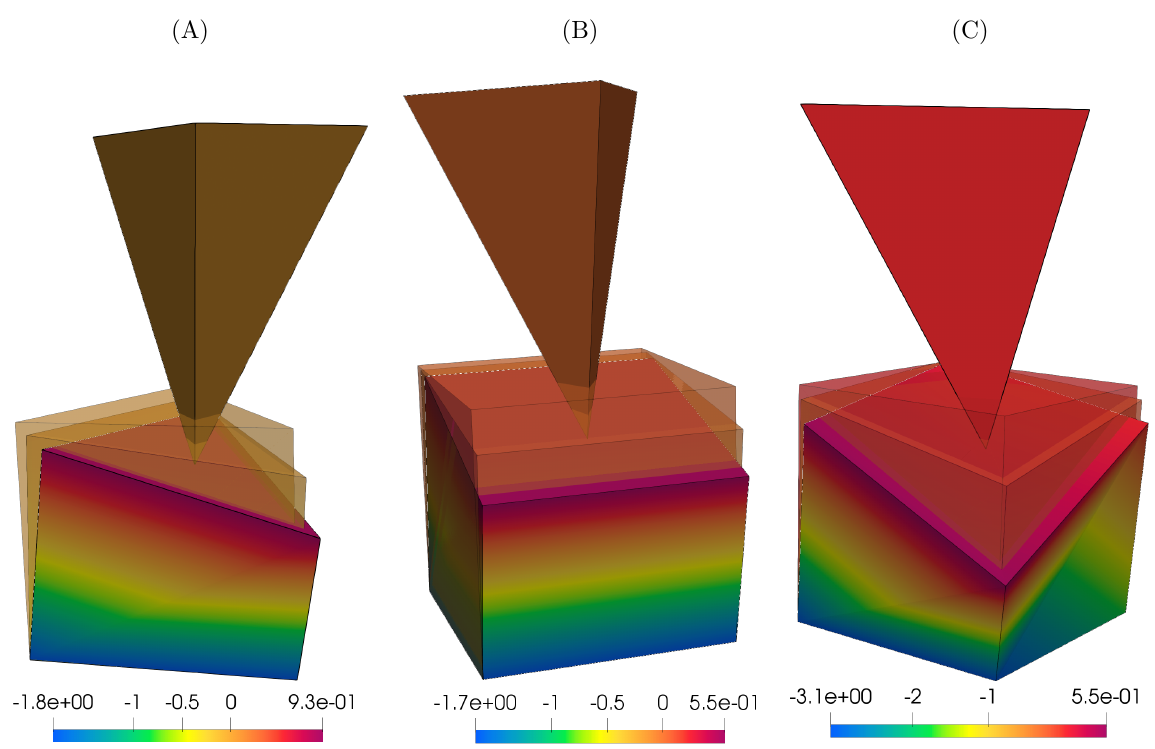
Figure 2. Node-to-segment contact with penalty formulation in the 3D domain: tests on a linear wedge and a linear brick element. Displayed geometries correspond to the 0th (undeformed configuration), 40th, and 60th steps of the computation. Coloring represents the vertical normal stress σ . A) A test on a linear wedge element. B) A test on a yy linear brick element, with the initial contact point at an axis of symmetry of the top surface. The deformed state remains symmetric along this axis. C) A test on a linear brick element with an arbitrary initial contact point. The apparent gap is only a consequence of the imprecise rendering of the resulting bilinear